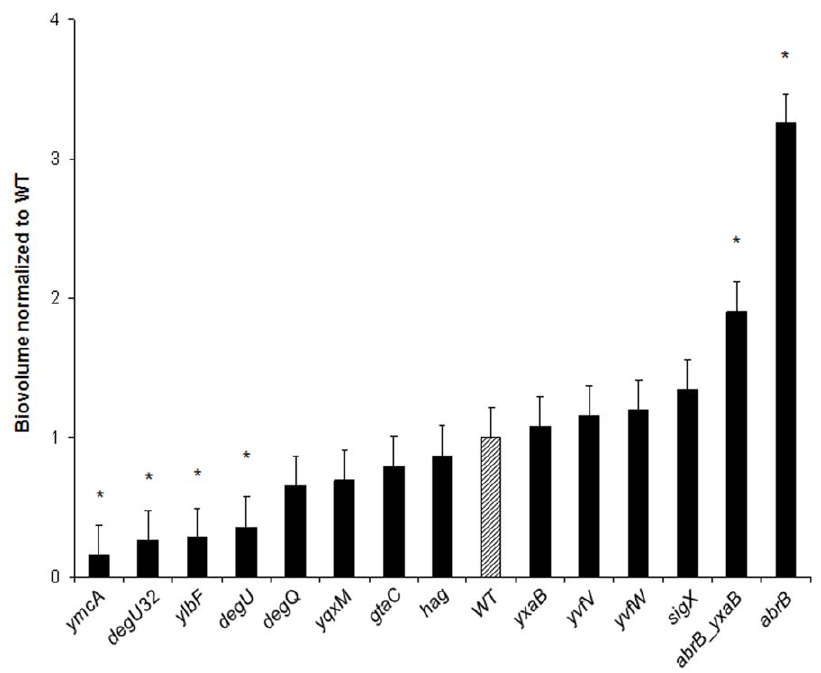
Figure 4. Biofilm biovolumes of the 14 B.subtilis mutant strains. Effects of mutations on the biofilm biovolumes of the 48h-biofilms obtained with the 14 mutants and wild-type strain (GM2812) (GFP-carrying strains). Biovolumes were normalized to wild-type (GM2812) and classified in ascending order. The error bars indicate the standard error and the statistically significant difference in biovolume obtained with the wild-type ( P , 0.05) is indicated by a star (*).